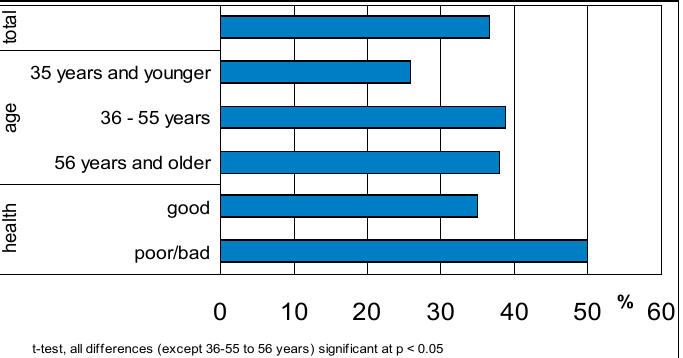
Figure 2. Sensitivity to noise (in % of respondents) for different individual characteristics.